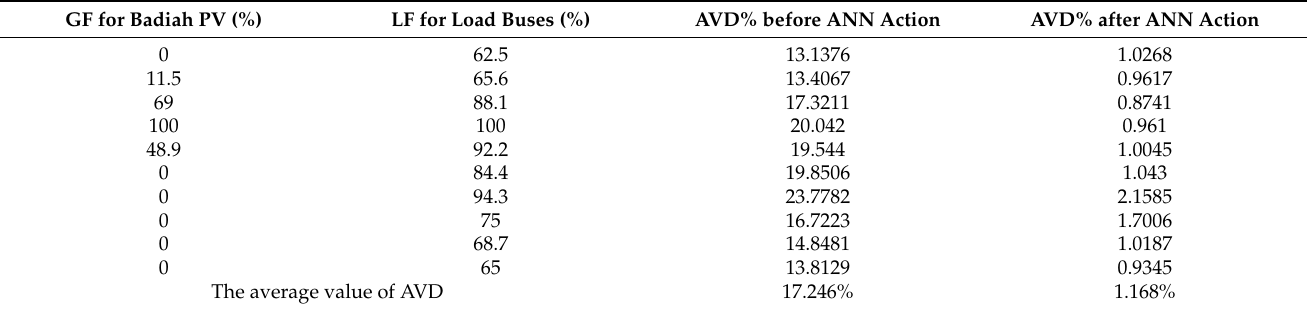
Table 10. Average voltage deviation for ANN controller using two STATCOMs.